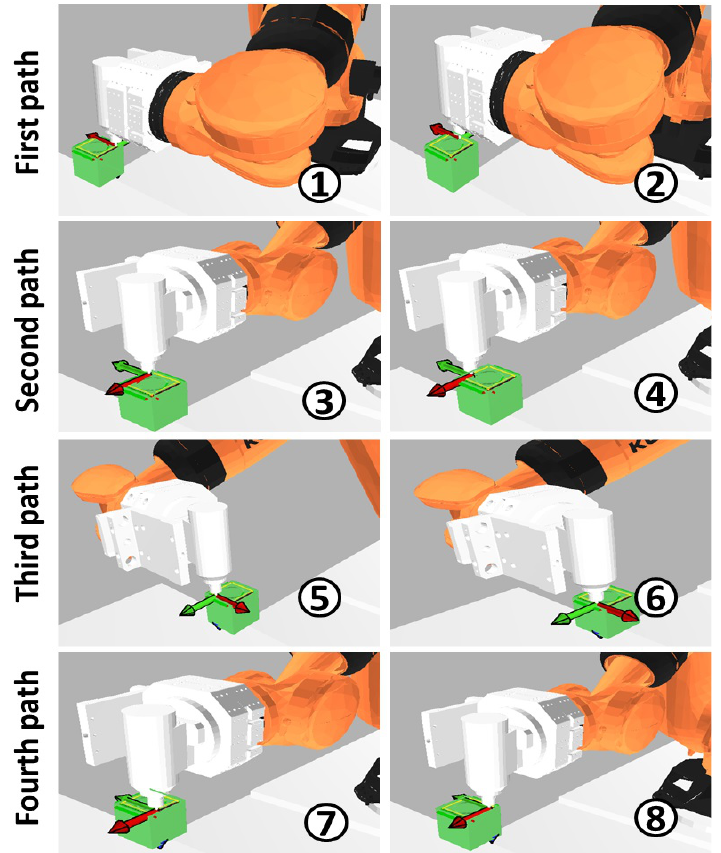
Figure 9. Sequence of robot movements for a four-edge machining task without optimization following the product